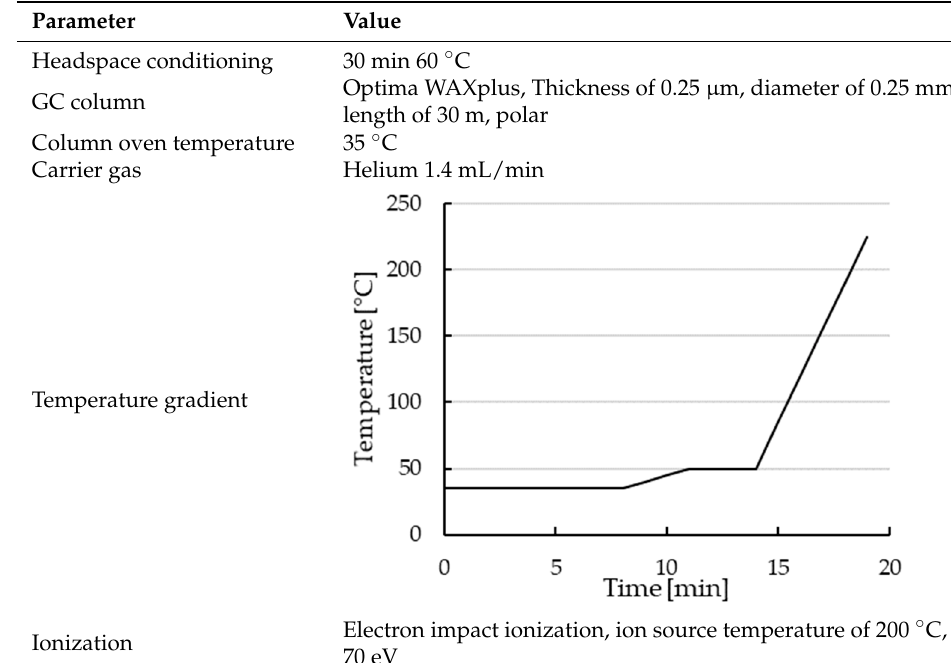
Table 3. Parameters of the HS GC–MS method.